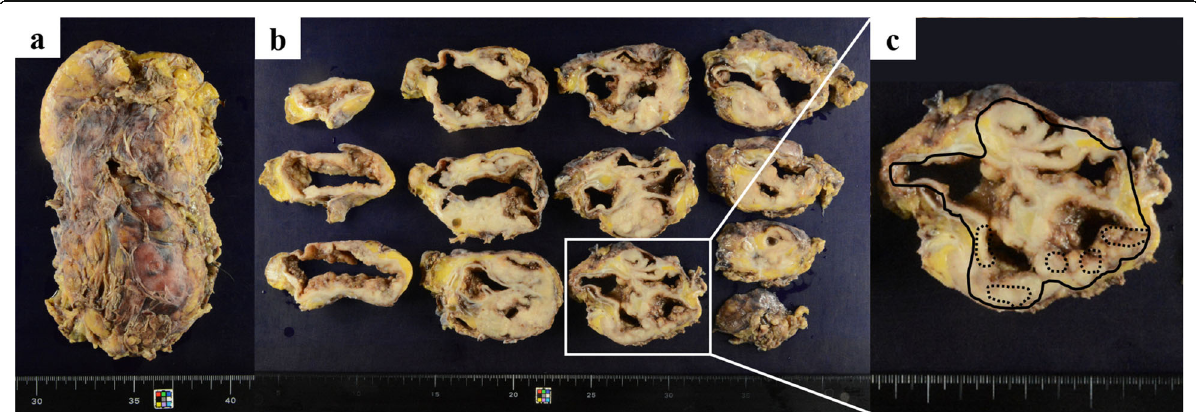
Fig. 3 Macroscopic findings in the resected specimen of a markedly enlarged left kidney ( a ). The cut surface appeared multicystic and solid, and most of the renal parenchyma was replaced with a whitish mass ( b ). The solid line shows high-grade urothelial carcinoma components, whereas several parts of the squamous cell differentiation components are indicated by dashed lines ( c )